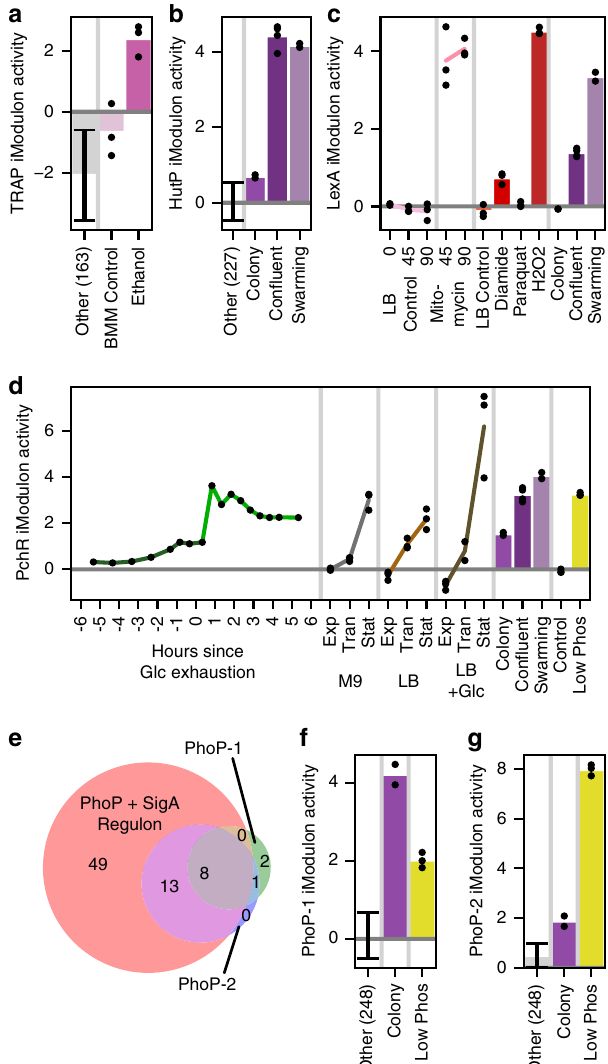
Fig. 2 iModulons provide a range of insights. Error bars: mean ± standard deviation; black dots indicate separate samples; vertical gray lines separate different experiments in the data set. Unless otherwise stated, “ Other ” category includes all conditions except sporulation and those shown, with the number of samples included in parentheses. a Tryptophan synthesis (TRAP) iModulon activity, which is unexpectedly elevated by ethanol (Supplementary Fig. 5a). The experiment was carried out in Belitsky minimal medium (BMM). The “ Other ” category excludes carbon source transition experiments, in which this iModulon exhibits technical